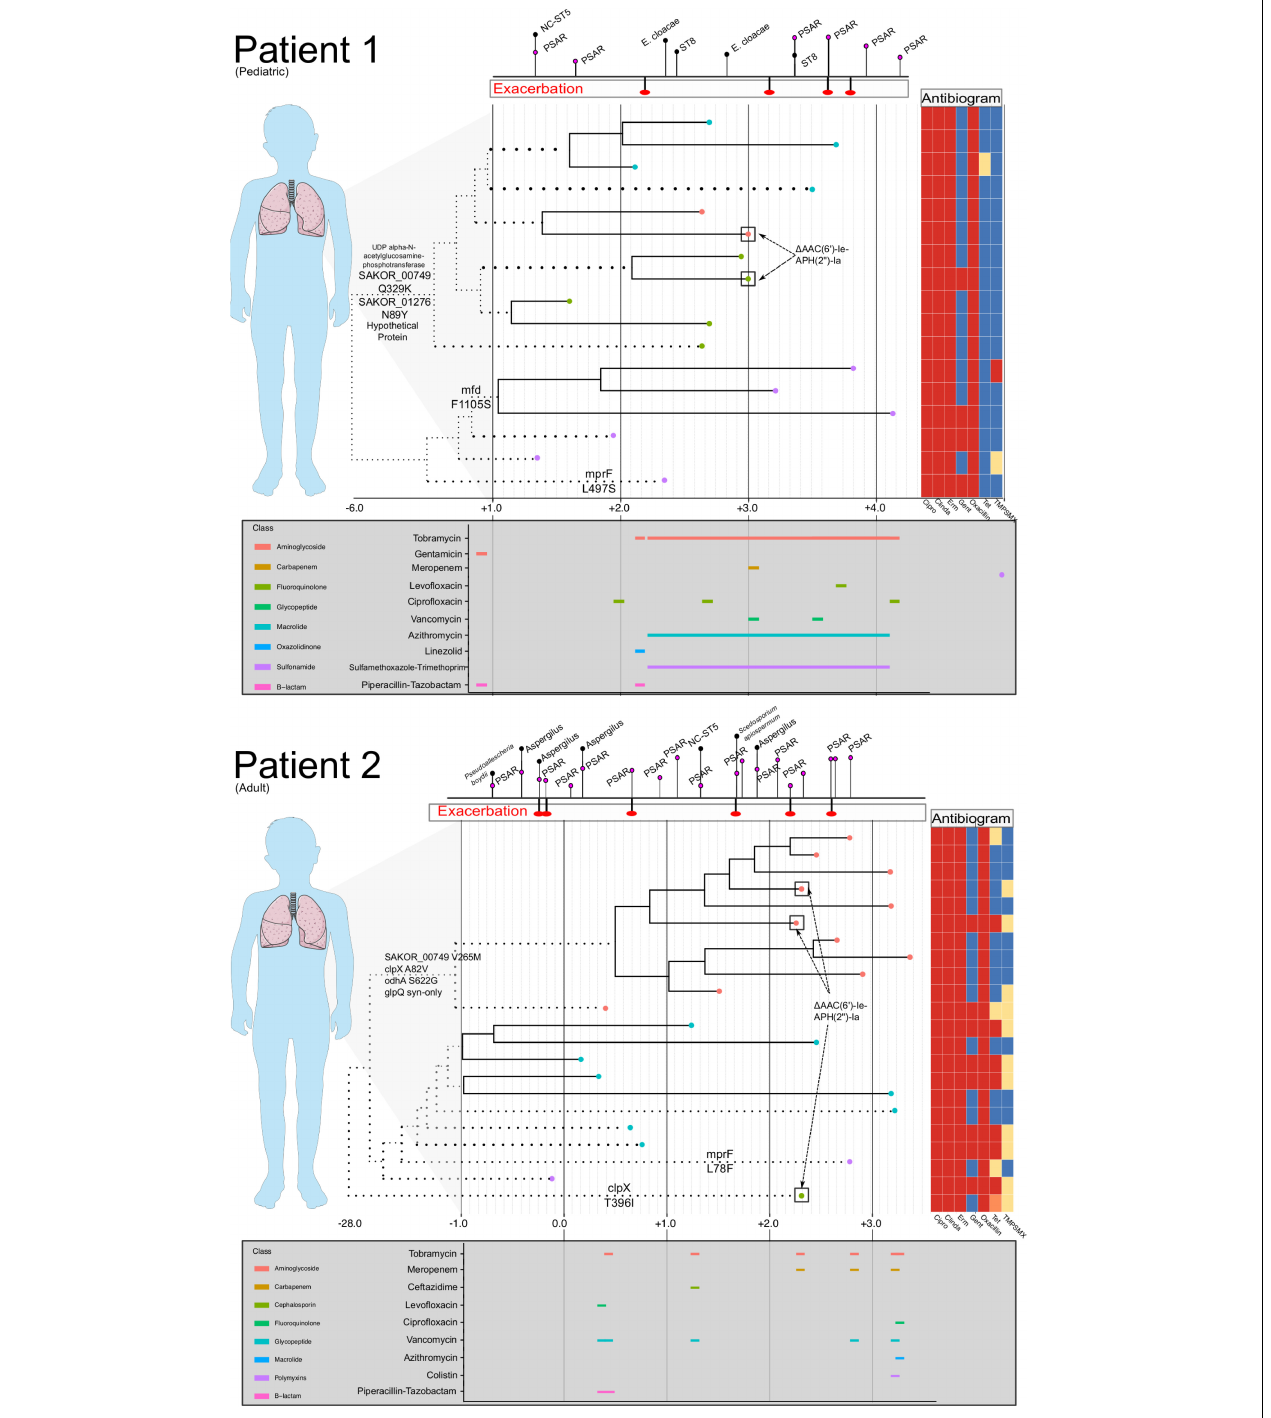
FIGURE 3 | Intrahost genomic epidemiology of Patients 1 and 2. For Patients 1 and 2, a time-scaled phylogeny (as shown in Figure 2 ) is shown, annotated with phenotypic antibiogram, antibiotic treatment, and notable genomic events. Time is scaled as years from the date of the first isolate in our study sample (Year 0). The phylogeny has been compressed to focus on events occurring during the study period and branches that have been scaled are dotted. Tip labels are colored based on intrahost sub-population structure. Above each time-series is a timeline dating CF exacerbations and identification of other respiratory organisms including Pseudomonas aeruginosa (PSAR) and non-clonal (NC) Staphylococcus aureus . Below each time series is a timeline showing antibiotic usage and drug class (legend to the left of the timeline) during the study period. For Patient 1, chronic azithromycin and trimethoprim/sulfamethoxazole was prescribed three times a week. Inhaled tobramycin was prescribed every other month (every 12 h, 28 days on, 28 days off). Instances where antibiograms varied among isolates collected on the same